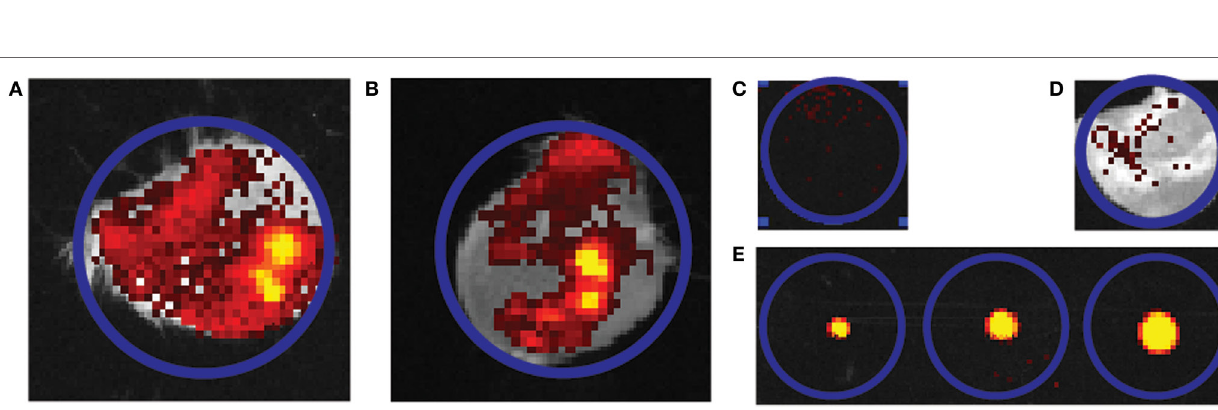
FigUre 3 | (a) Hydrodynamic diameter of diphtheria toxoid (DT) (8.72 ± 2.83 nm, mean ± SD, n = 3). (B) Hydrodynamic diameter of tetanus toxoid (TT) (13.5 ± 5.6 nm, mean ± SD, n = 3). (c) Release of DT and TT in release buffer measured by intrinsic fluorescence (D) release of imiquimod (IMQ) from nanoporous microneedle arrays in phosphate-buffered saline measured by high-performance liquid